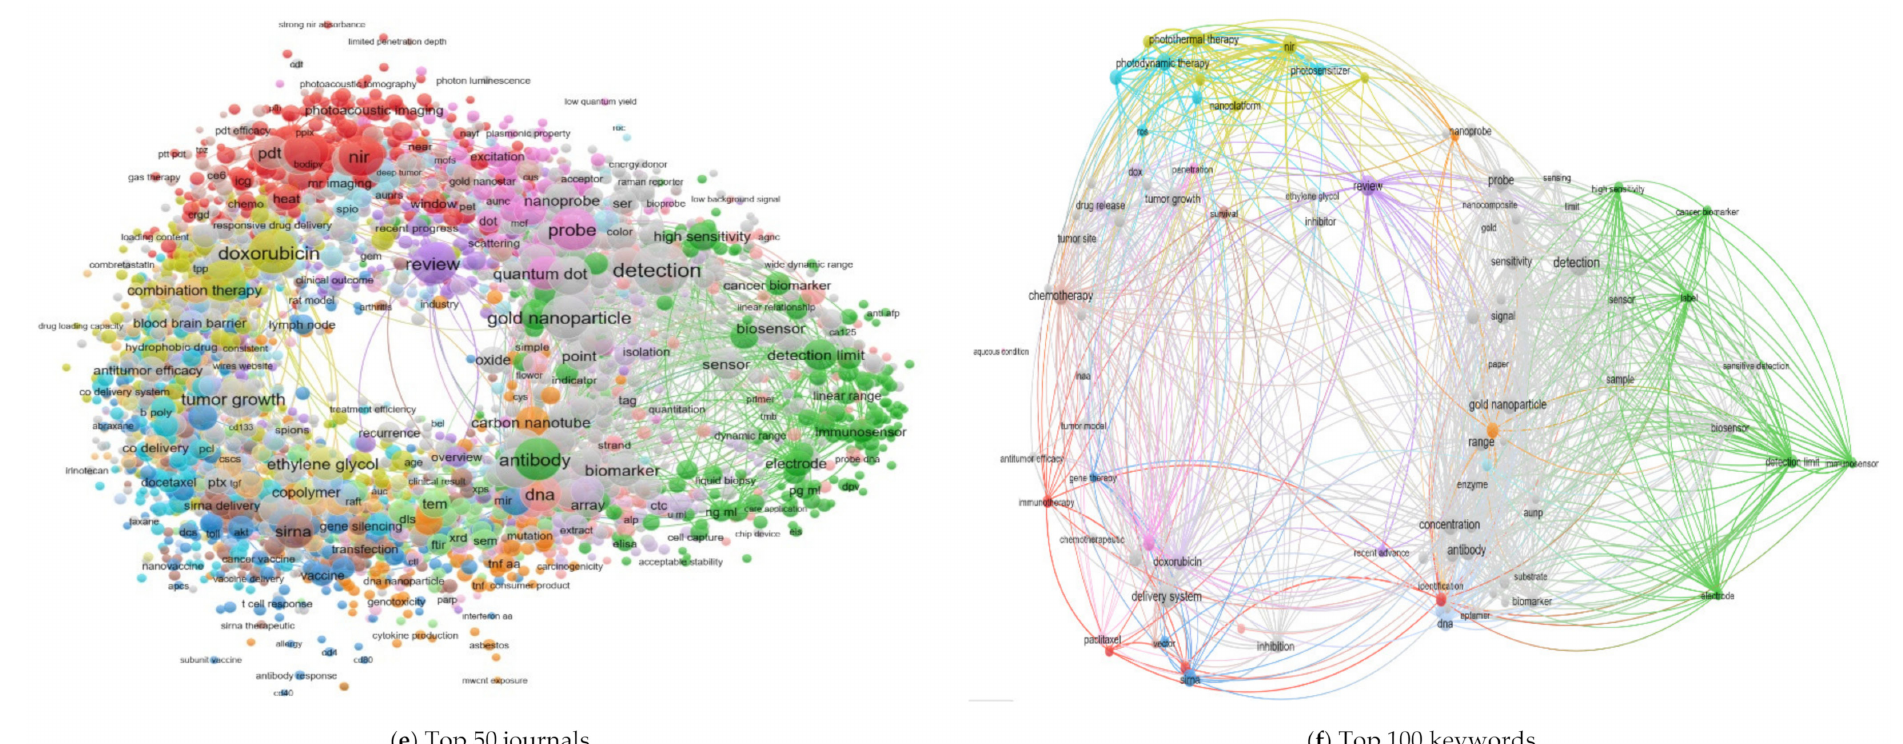
Figure 5. The network of co-occurring keywords in the area of cancer nanotechnology during 2000–2021 for the three scenarios in ( a , c , e ); their corresponding top 100 keywords shown in ( b , d , f